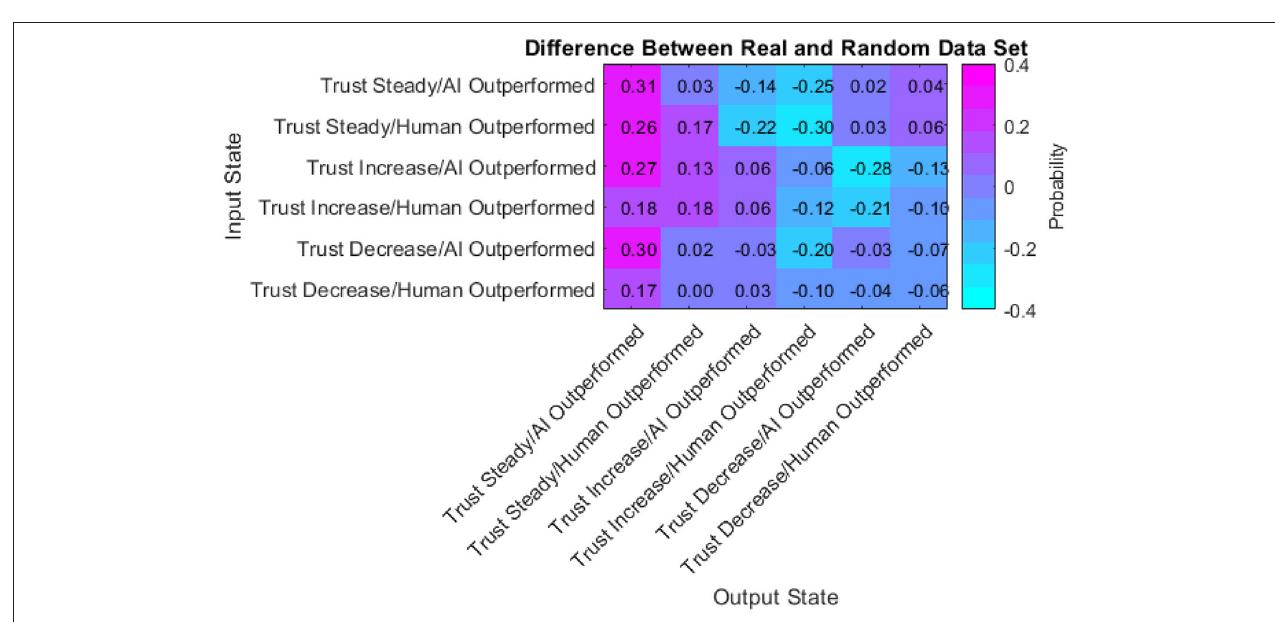
FIGURE 17 | Difference between real and random